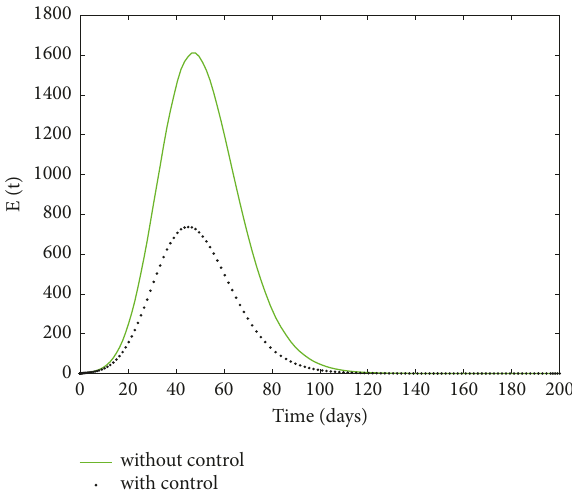
Figure 12: Behaviour of the exposed individuals with and without lockdown control.